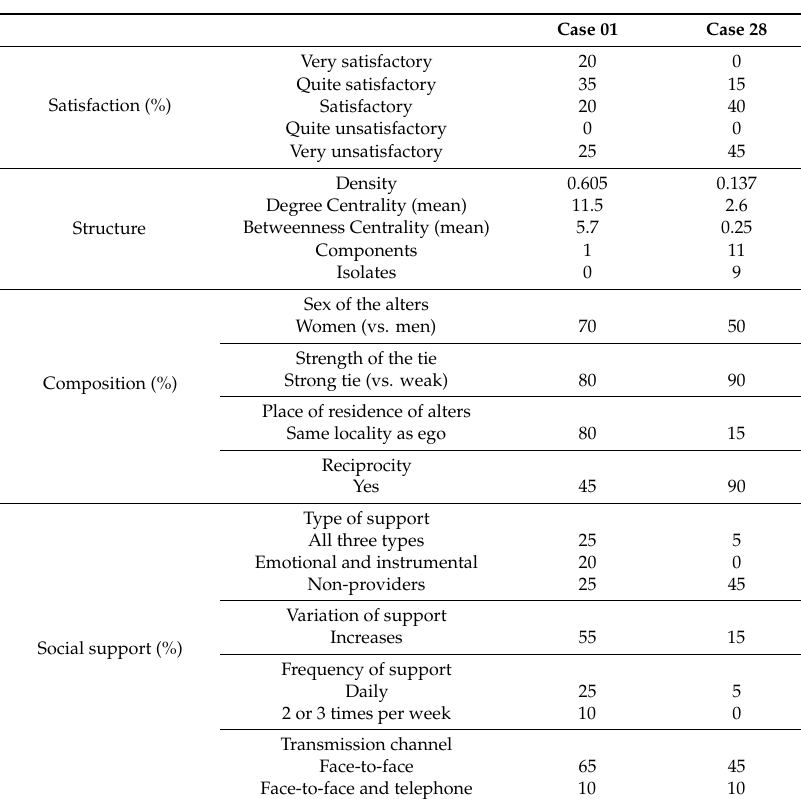
Table 9. Descriptive analysis of social support at the ego